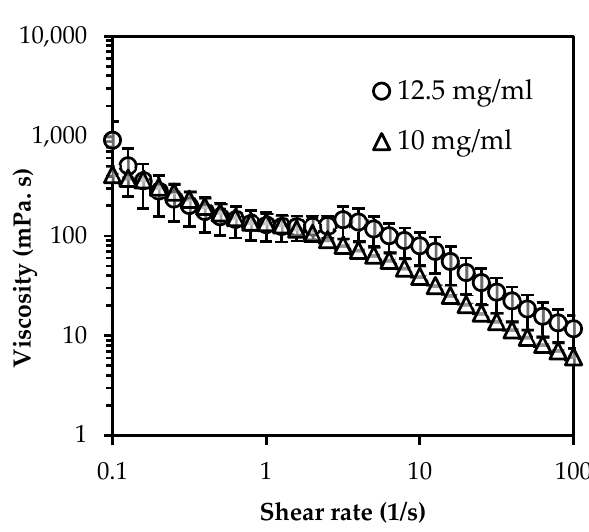
Figure A1. The viscosity of ChNC dispersions as function of shear rate. Table A1. DPPH inhibition (%) values of deacetylated chitin samples after 30 min of incubation with DPPH radical solution.